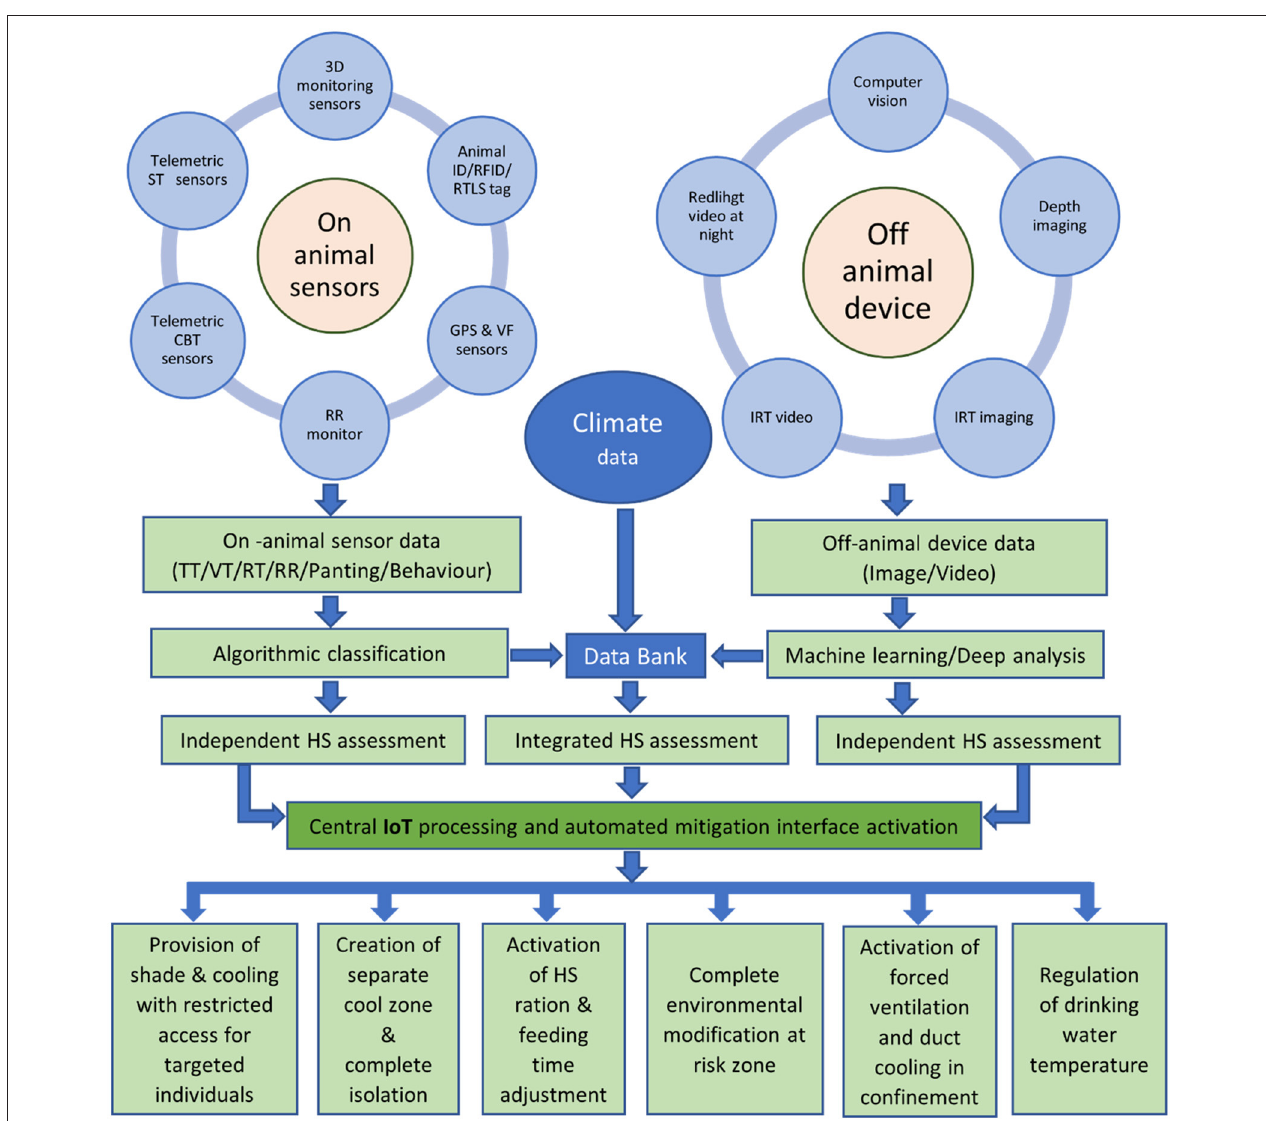
FIGURE 2 | Automated heat stress (HS) monitoring and mitigation protocol. [RFID, radio-frequency identification; RTLS, real-time location sensor; GPS, global positioning system; VF, virtual fencing; RR, respiration rate; CBT, core body temperature; ST, skin surface temperature; IRT, infra-red thermography; TT, tympanic temperature; VT, vaginal temperature; RT, rectal temperature; IoT, internet of things].